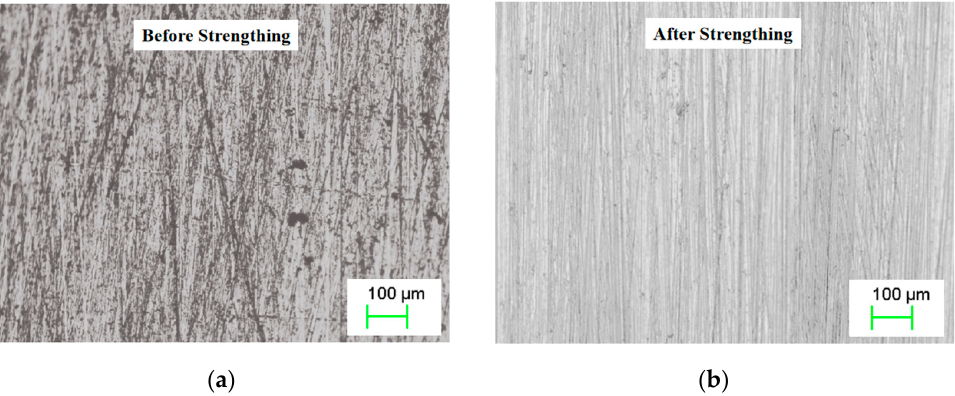
Figure 18. Microscopic morphology of the blade surface. ( a ) Before robotic ultrasonic strengthening; ( b ) after robotic ultrasonic strengthening. ( b ) after robotic ultrasonic